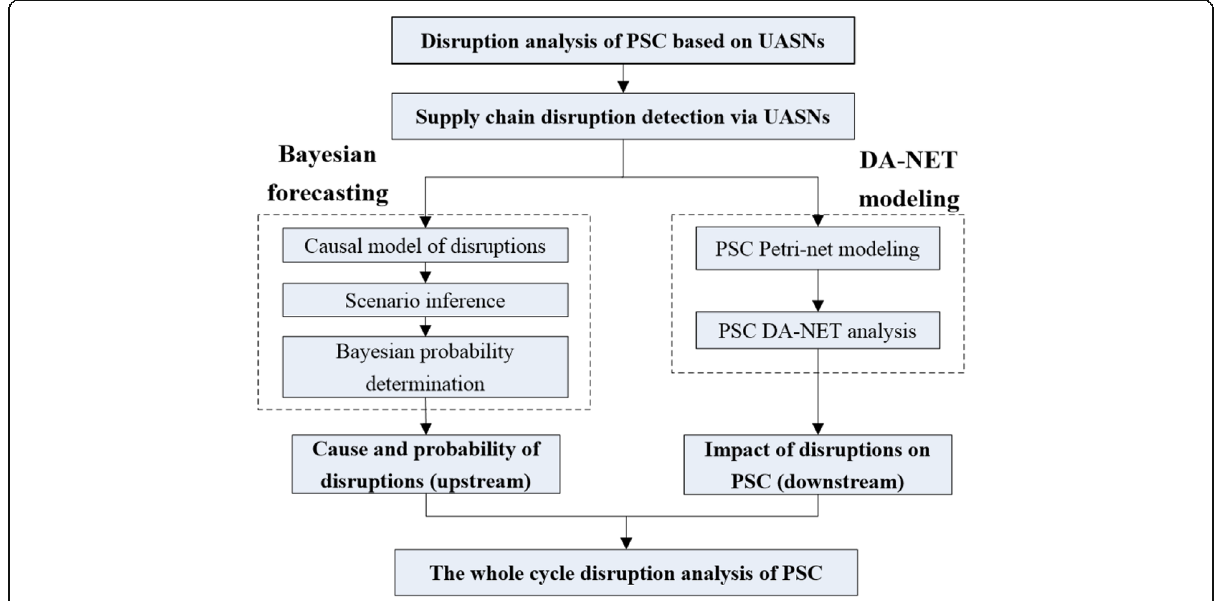
Fig. 2 The methodology of the paper